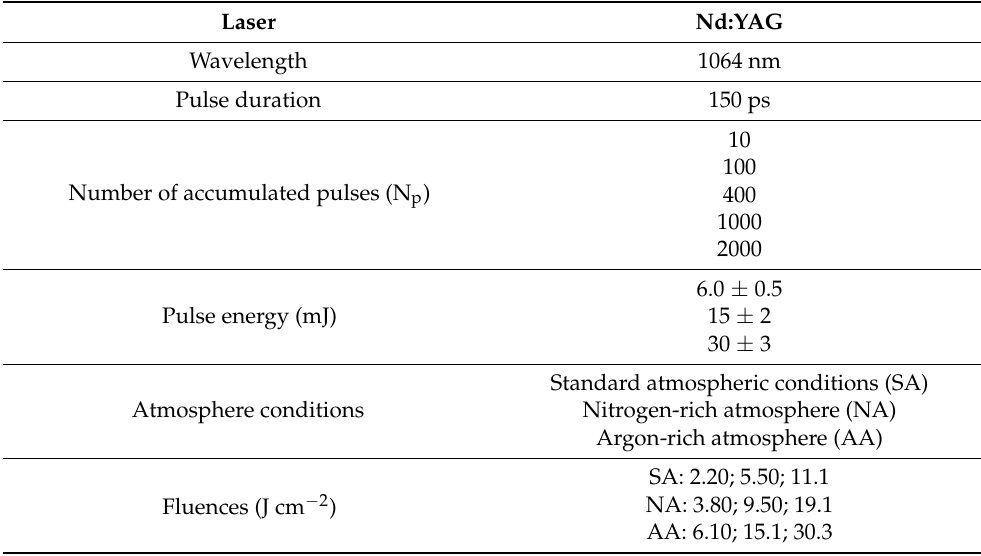
Table 1. The conditions and parameters of Nd:YAG picosecond laser irradiation in the interaction with Nimonic 263 superalloy. Laser Nd:YAG Wavelength 1064 nm Pulse duration 150 ps